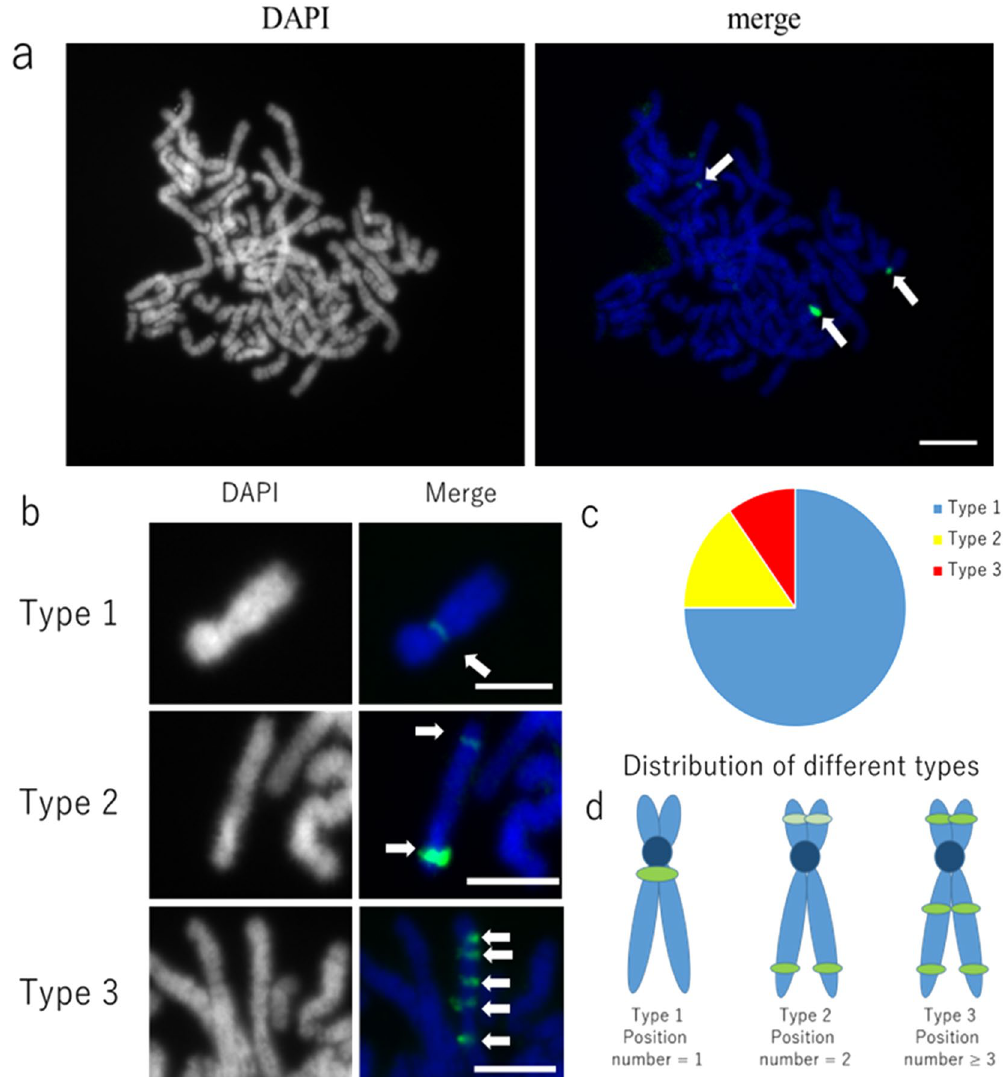
Figure 5. Localization of Arabidopsi s genome segment Ch2-2 by FISH to human chromosomes in the hybrid cell line. ( a ) Probe Ch2-2 (green) hybridized to different chromosomes (arrows). Chromosomes were counterstained using DAPI (gray pseudocolor or blue). ( b ) Different types of chromosomal location of the Ch2-2 probe. ( c ) Relative proportion of chromosomes with different Ch2-2 signal distributions. 20 cells were examined by FISH for Ch2-2 localization. ( d ) Diagrammatic representation of the three types of chromosomes. Scale bars, 5